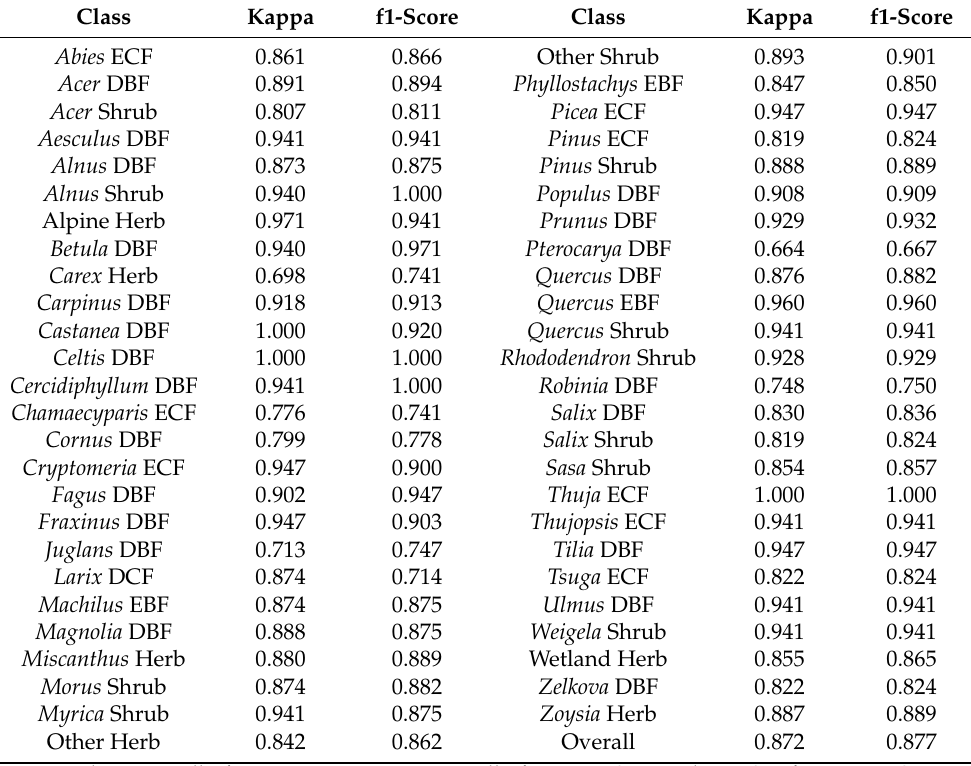
Table 5. Class-wise performance of GPE level classification of plant